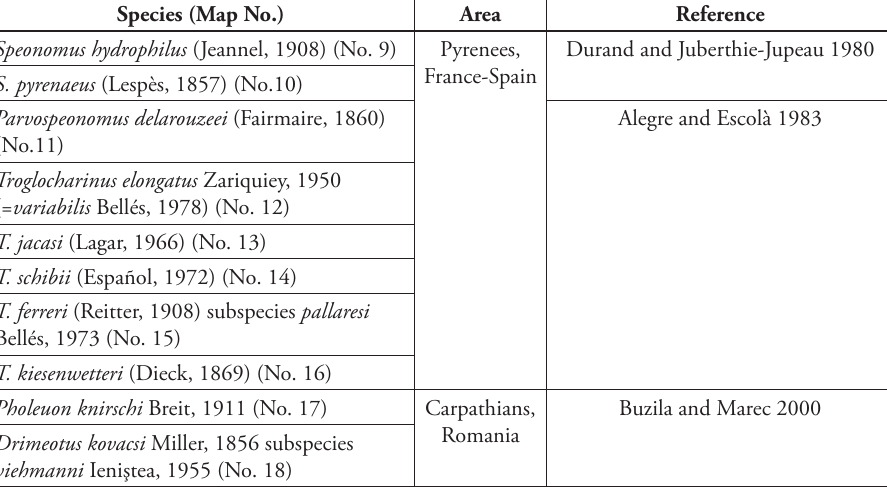
table 2. Species of Leptodorini for which chromosome details have been published: species with map No. As shown in Fig. 1, area from which the material was collected, and publication reference. Species (Map